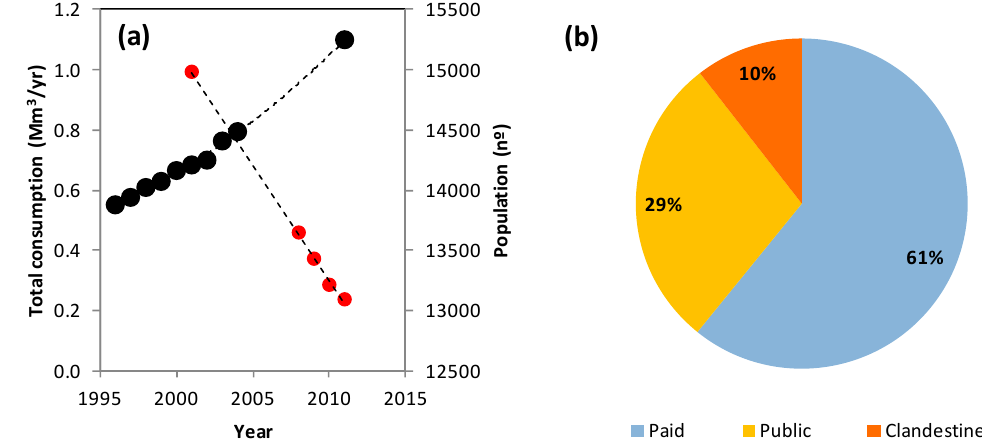
Figure 5. ( a ) Consumption of groundwater in Vila Pouca de Aguiar in the period 1995–2011, based on municipal records. Evolution of resident population in the period 2001–2011 (https://www.pordata.pt/). ( b ) Groundwater consumption as function of type: paid by residents, public use (unpaid) and clandestine or related to network losses.